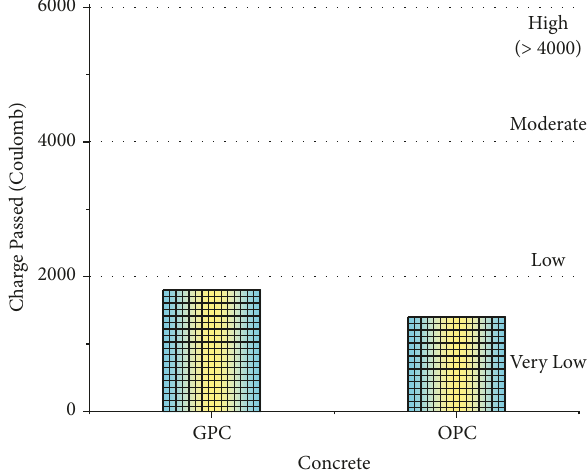
Figure 13: Rapid Chloride Permeability Test results for GPC and OPC mix.